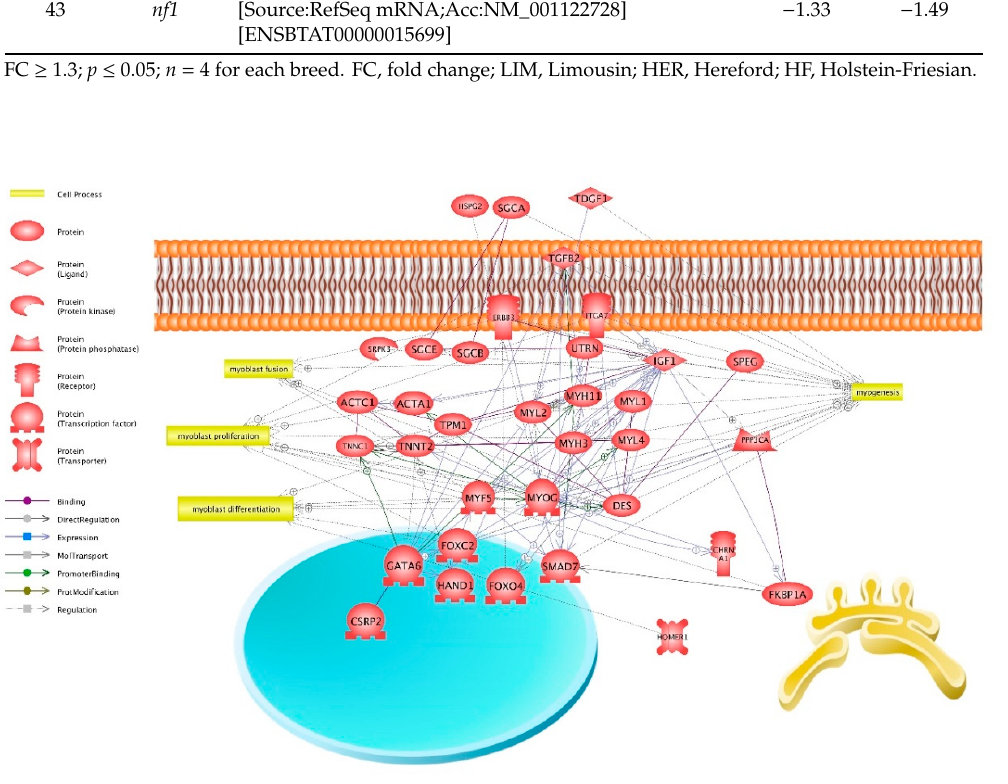
Figure 3. Intergene interaction network of identified common genes for beef breeds and their classification to biological processes associated with muscle organ development ( Pathway Studio ).